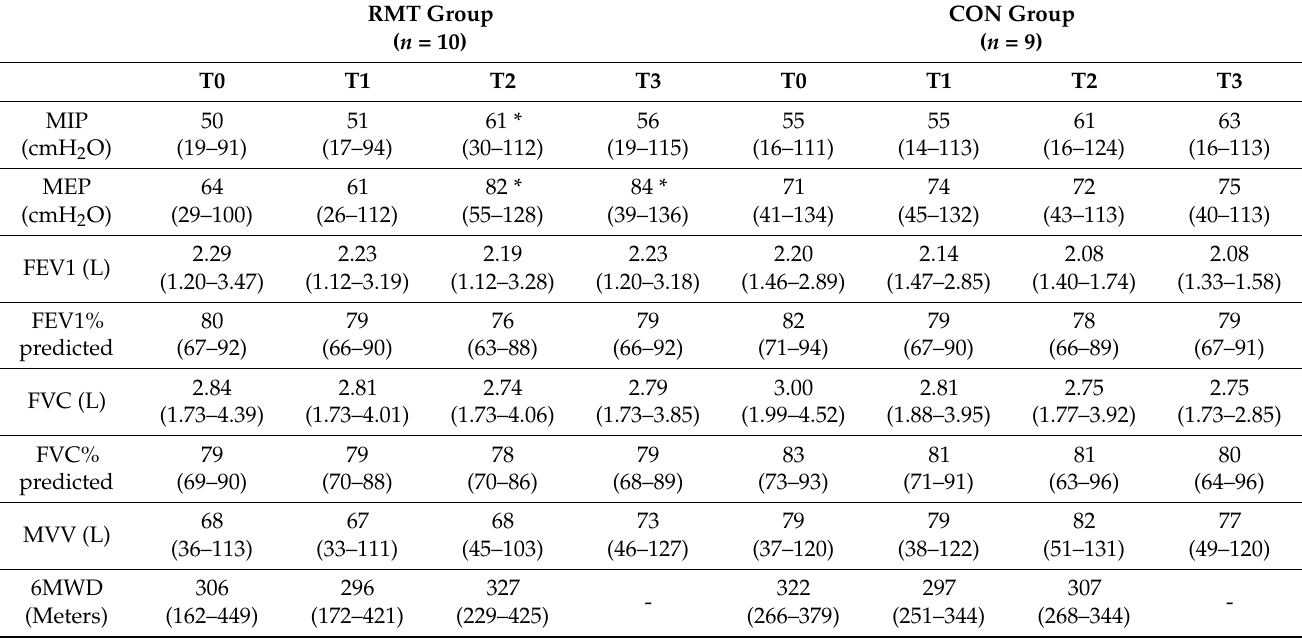
Table 3. Outcome measures in both the training and control groups. * p < 0.05 respect to T0 measured with paired-samples